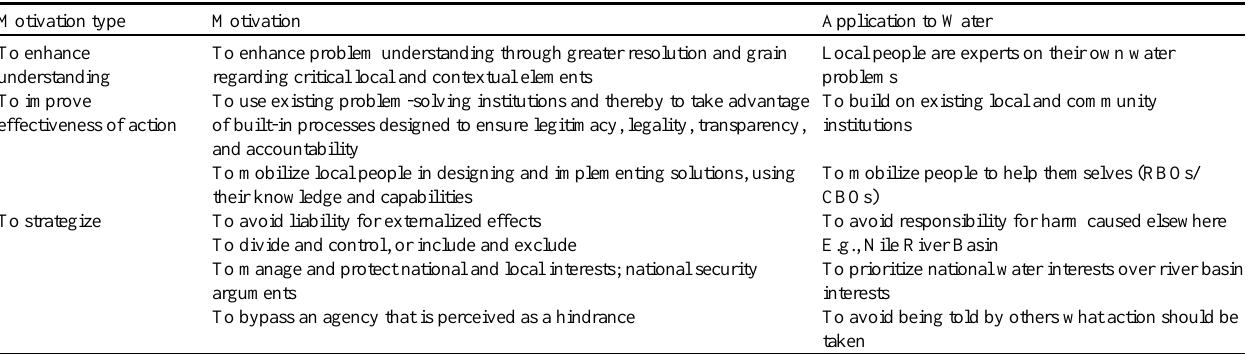
Table 4 . Reasons for scaling down water. RBOs = river basin organizations, CBO = community-based